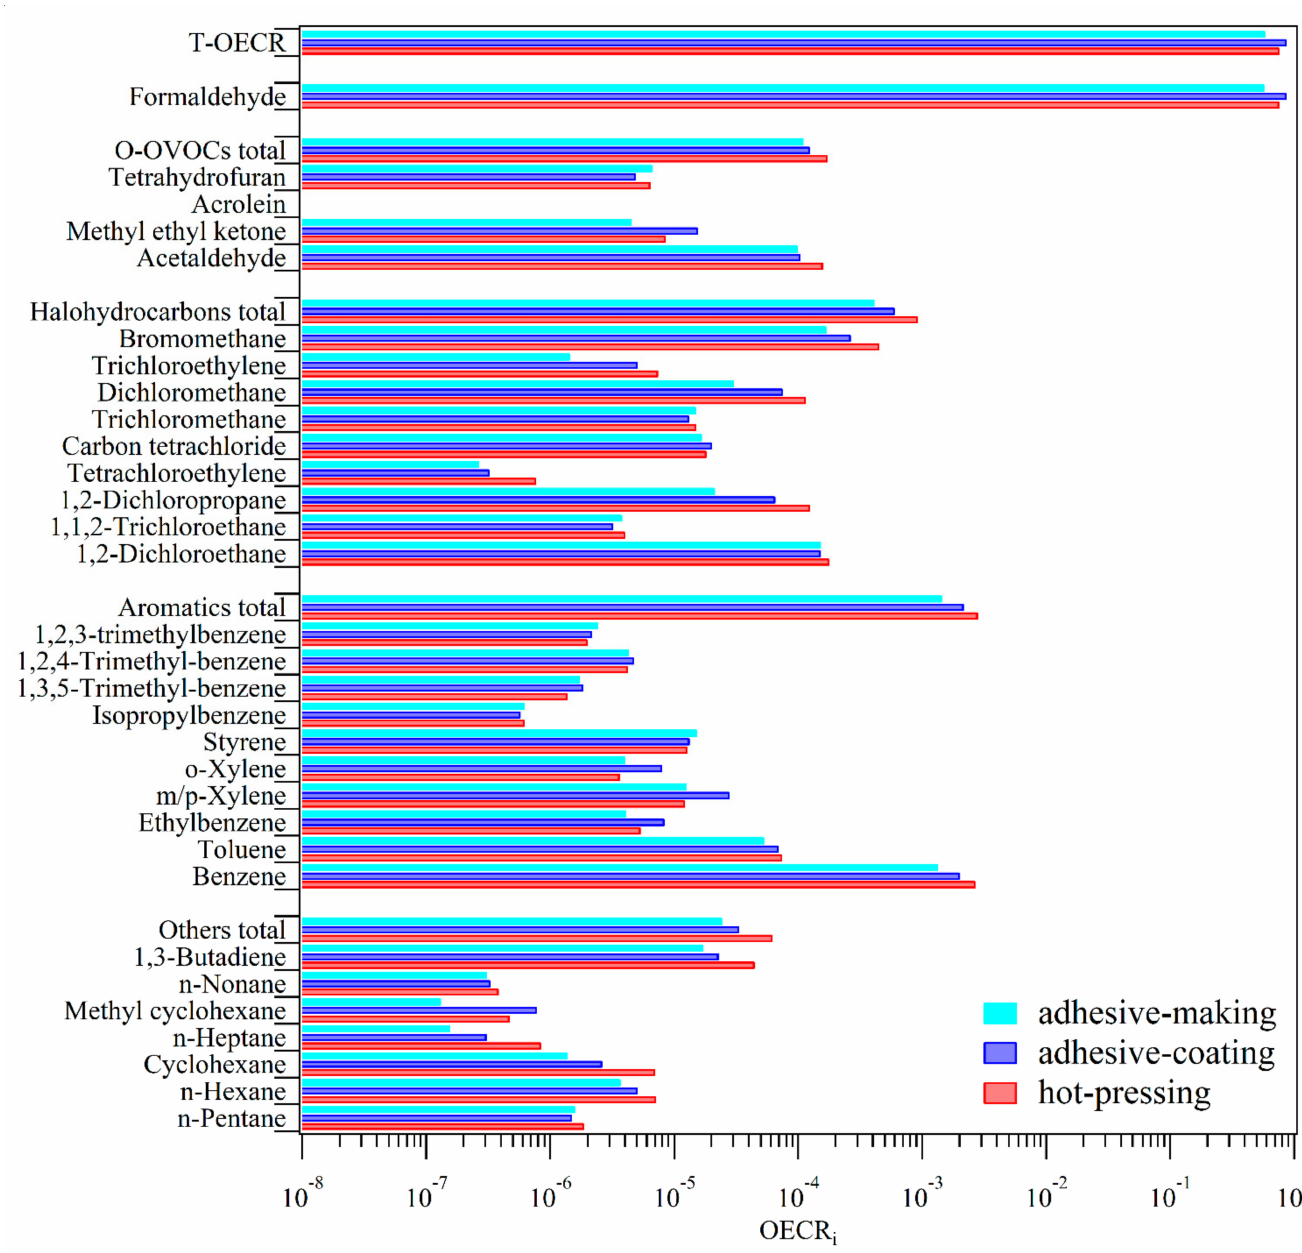
Figure 7. Occupational exposure cancer risk for individual VOC species (OECR) and total VOCs (T-OECR) from three processes of the plywood manufacturing